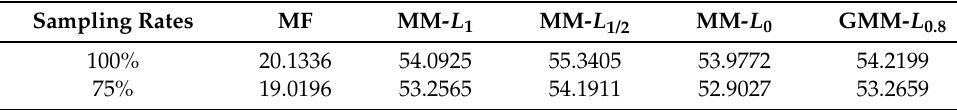
Table 7. The TBR of the SAR Data of the Complex